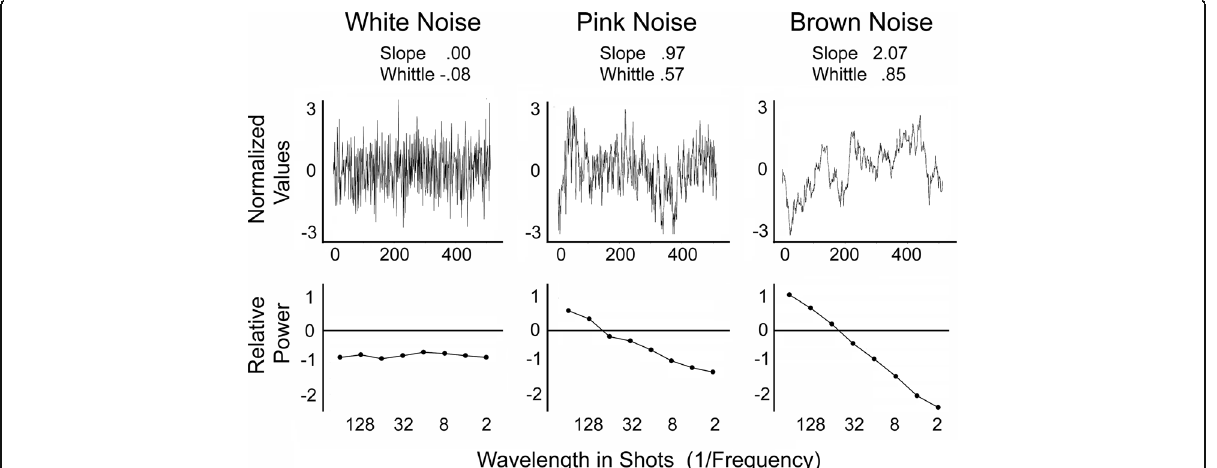
Fig. 1 Three types of temporal noise. The top panels show 512-element samples of white (or random) noise, pink (or fractal) noise, and brown (or Brownian) noise. Slope values refer to the exponent (alpha) in the expression 1/ f α and Whittle values refer to the exact local Whittle estimator of long-range dependency in the data (Shimotsu & Phillips, 2005). See the text for explanations of both. The bottom panels show the power spectra for each patch of noise for wavelengths (traveling windows along the time-series vector) between 2 8 to 2 1